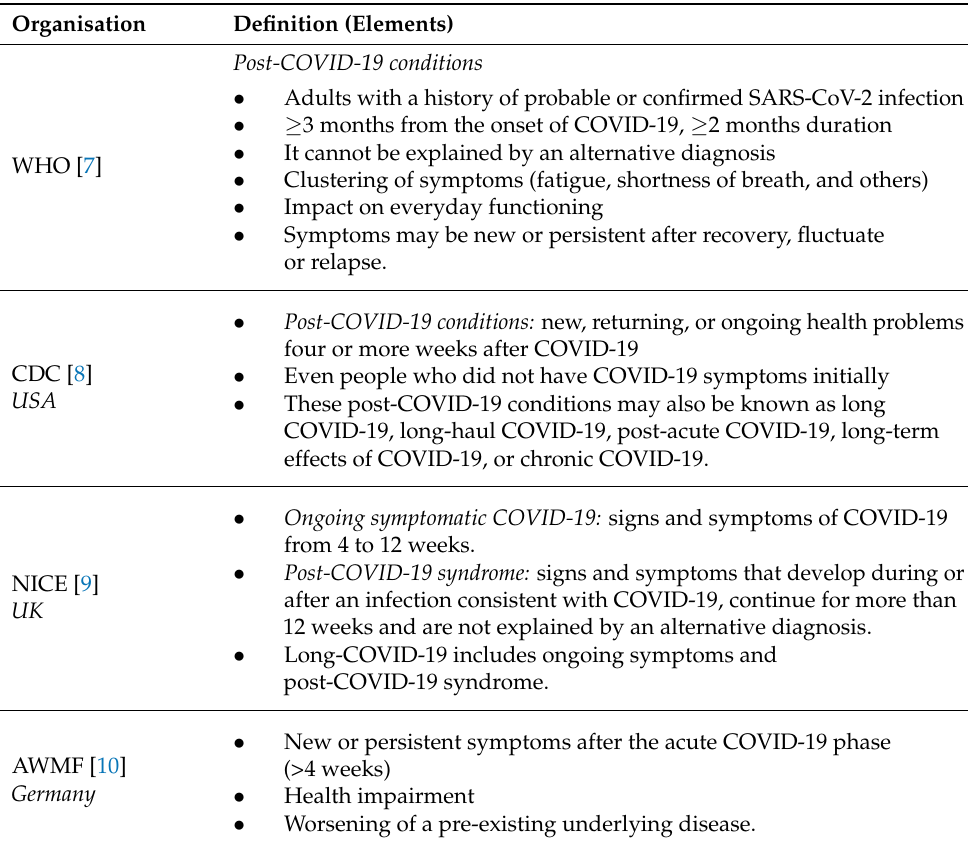
Table 1. Various definitions for the longer-term consequences of SARS-CoV-2